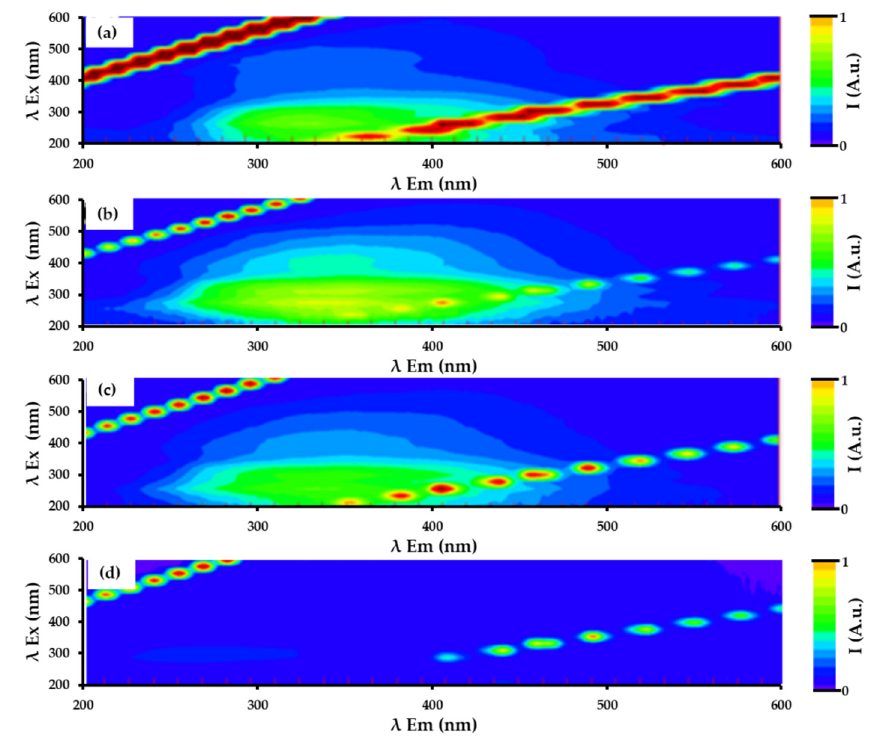
Figure 6. 2D fluorescence spectra of feed ( a ) and permeates of UF experiments performed with M0 ( b ), M8 ( c ), and M15 ( d ), respectively.